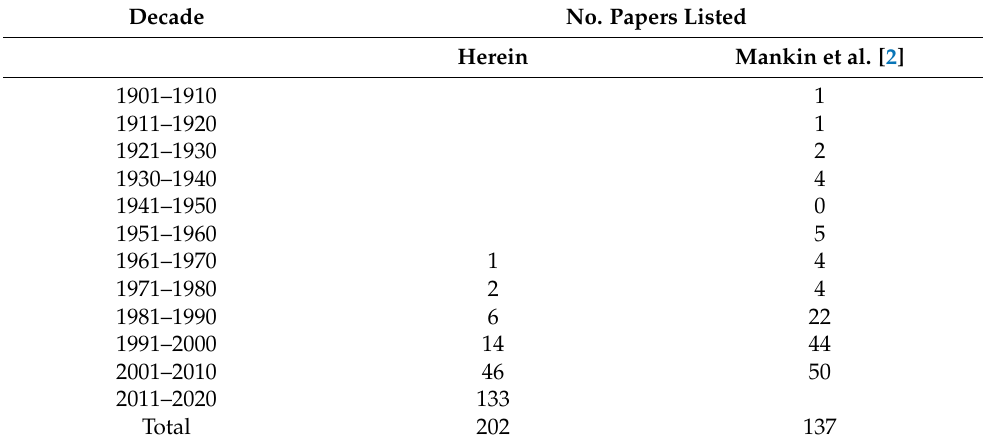
Table 1. Increases over decades in reports describing insect acoustic detection